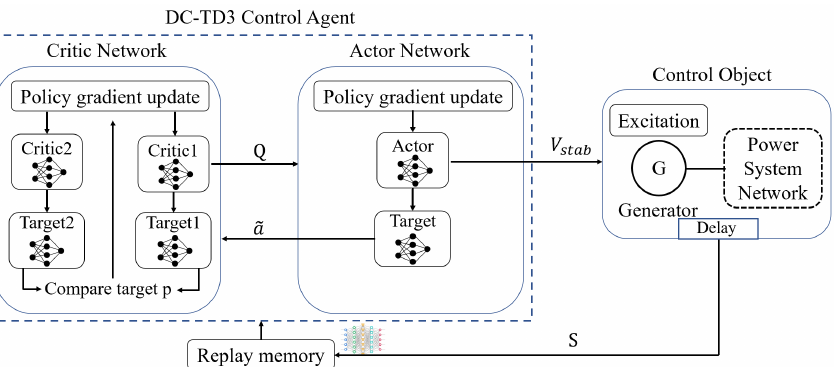
Figure 3. Internal structure and the implementation diagram of the twin-delayed deep deterministic policy gradient